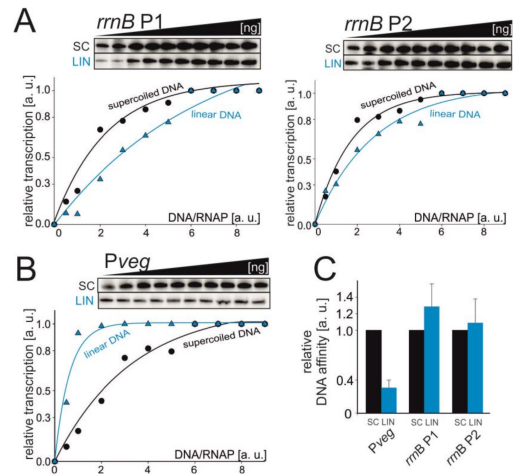
Figure 4. The affinity of RNAP for promoter DNA. Multiple-round transcriptions were carried as a function of the increasing DNA/RNAP ratio. The tested promoters were rrn B P1+P2 ( A ) and P veg ( B ). Primary data are shown above the graphs. The maximum signal in the plateau phase was set as 1. SC—supercoiled and LIN—linear DNA templates. The experiments were conducted at least four times with similar results. Representative primary data are shown. ( C ) Graphical comparison of relative affinities of RNAP for P veg and rrn B P1+P2 promoters. The bars show relative concentrations of promoter DNA at which the activity of RNAP was 50%. The affinity of RNAP for SC promoter DNA was set as 1 for each